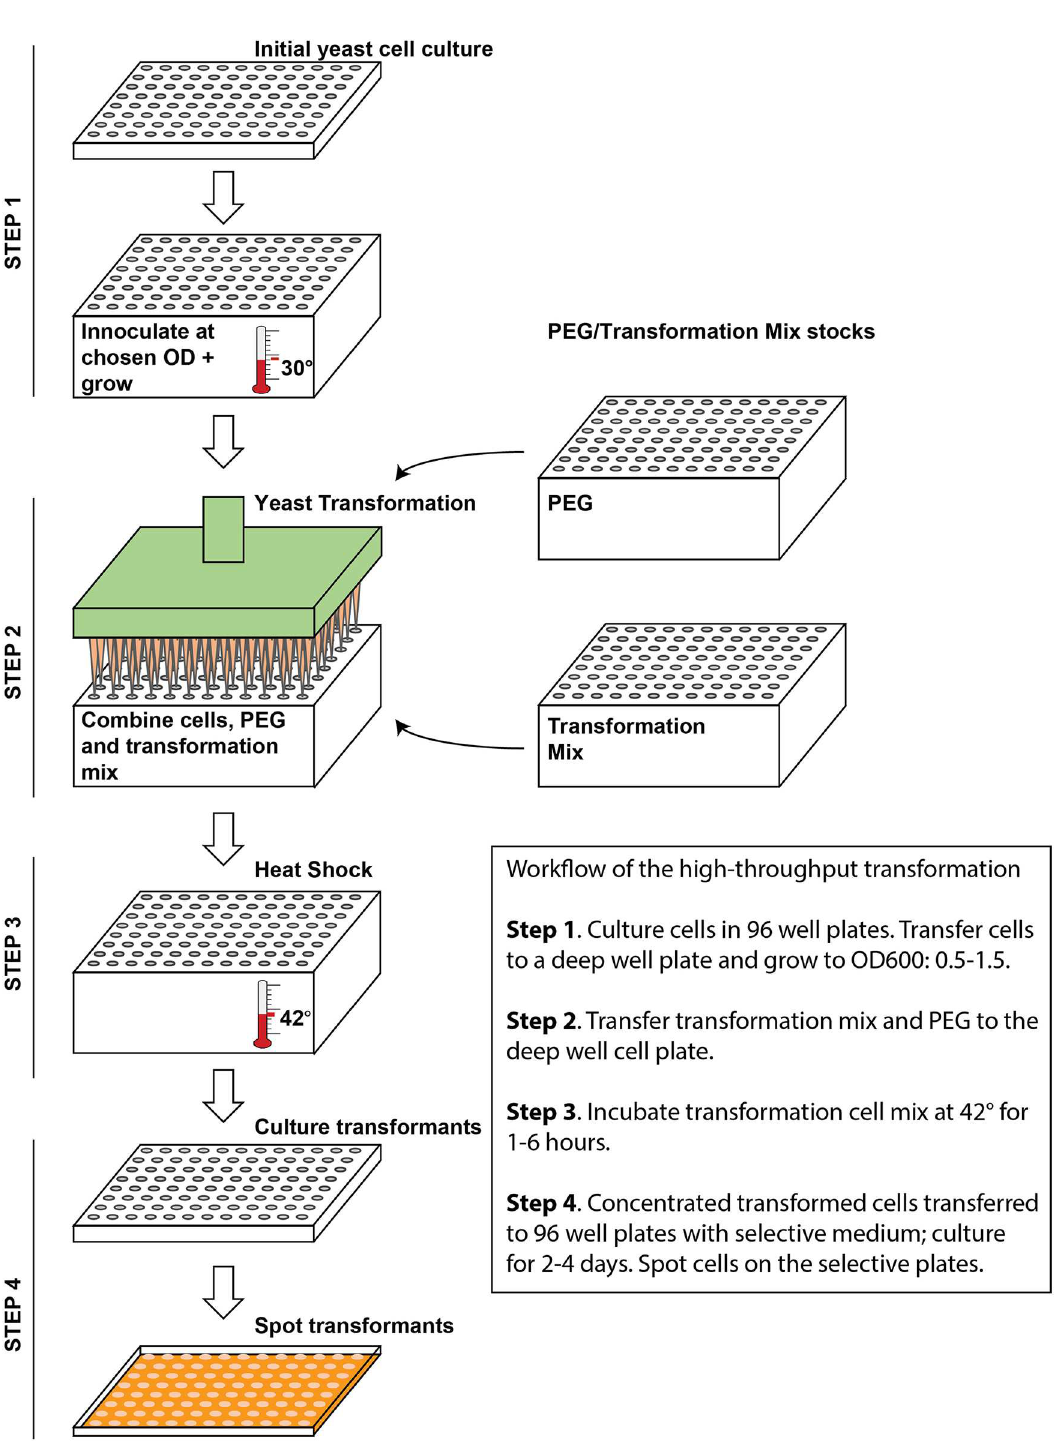
Fig 4. Schematic model of yeast transformation using liquid handling robot. Step 1, Inoculate overnight culture to the deep well plate. Grow another 2 ½ -4 hours to recover cells to the mid-log phase. Step 2, Prepareplasmidand transformation mix to transformation. Normally, an OD 600 range of 0.4–1.5, (cid:21) 100ngplasmidor 4500 ng PCR product is optimal for our automatedtransformation method. Step 3, Heat shock of the transformants for 3–6 hours. Step 4, Transfer the transformed cells to a liquid selective media plate to grow another 2–4 days. Pin the transformed strains onto appropriate selective media to generate the new library.